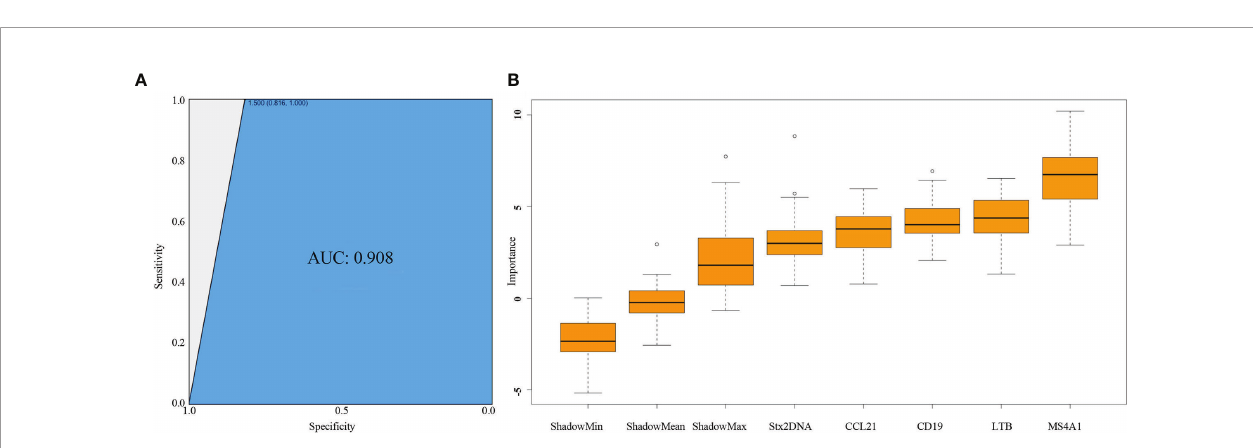
FIGURE 3 | Assessment of Random Forest model using ROC curve and Boruta method. (A) Assessment of classi fi cation performance of random forest model using area under ROC (AUC). Sensitivity (y-axis) represents the fraction of samples with positive Stx2 expression that the test correctly identi fi es as positive. Speci fi city (x-axis) represents the fraction of samples without Stx2 expression that the test correctly identi fi es as negative. (B) Rank of host immune genes as markers for Stx2 expression prediction using Boruta method. ○ represents the outliers in each